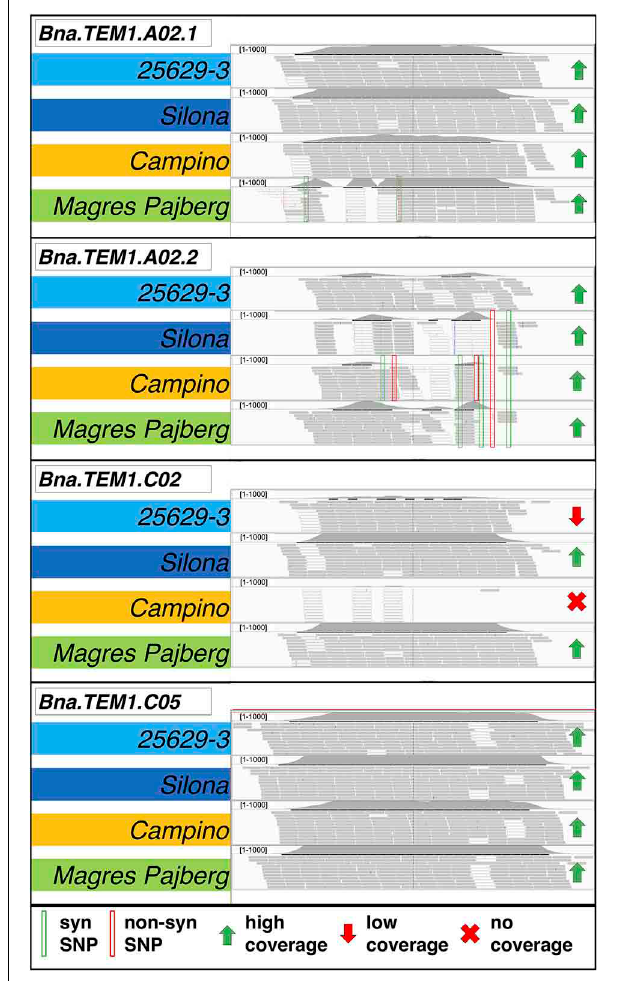
FIGURE 2 | Mapping of captured sequences from four different B. napus morphotypes for paralogs of the gene TEMPRANILLO 1 (Bna.TEM1) on chromosomes A02 (two copies, one showing synonymous SNP variation and one with both non-synonymous and synonymous SNPs), C02 (showing copy-number variation and presence-absence variation) and C05 (no polymorphisms). Copy-number variation (CNV) is estimated by variation in the normalized average read density over the entire length of the captured gene sequences of all expected paralogs in the four genotypes. Gray bars indicate uniquely mapped reads, white bar indicate ambiguously mapped reads. Details on the morphotypes of the four accessions are provided in the text.